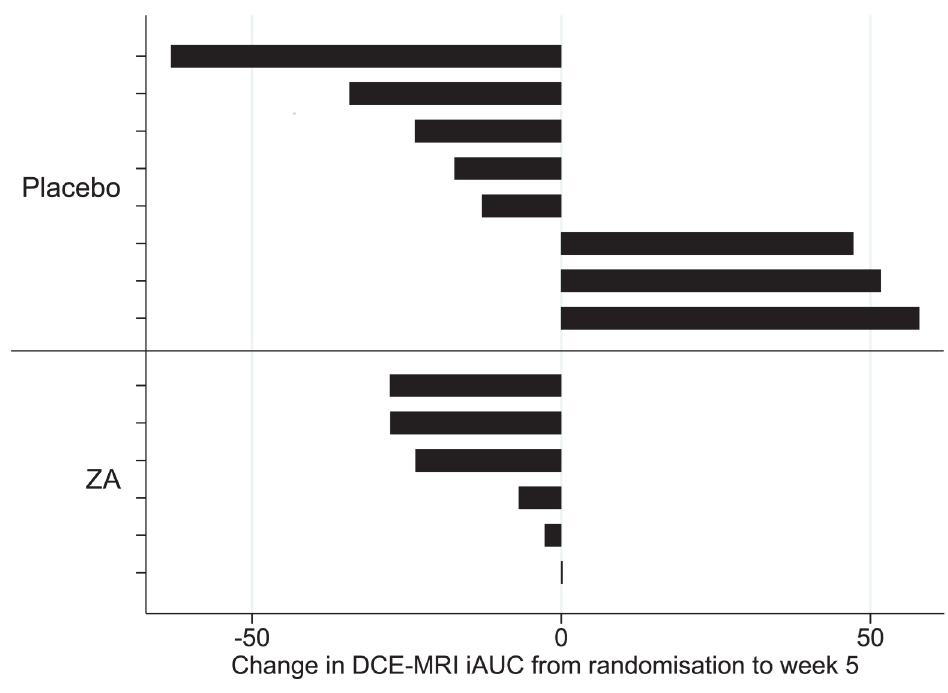
Fig 3. Change in DCE iAUC from baseline to week 5 (complete case data).